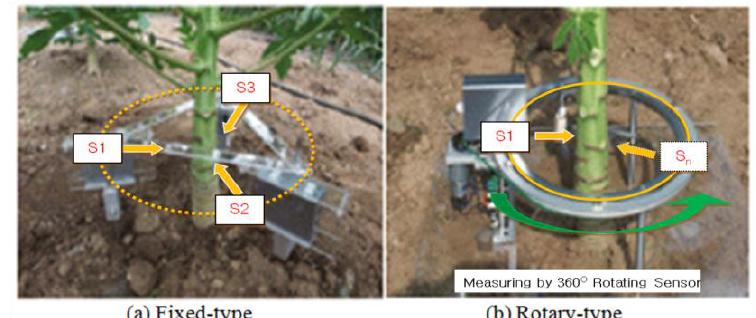
Figure 22. Field Test Environments (fixed-type and